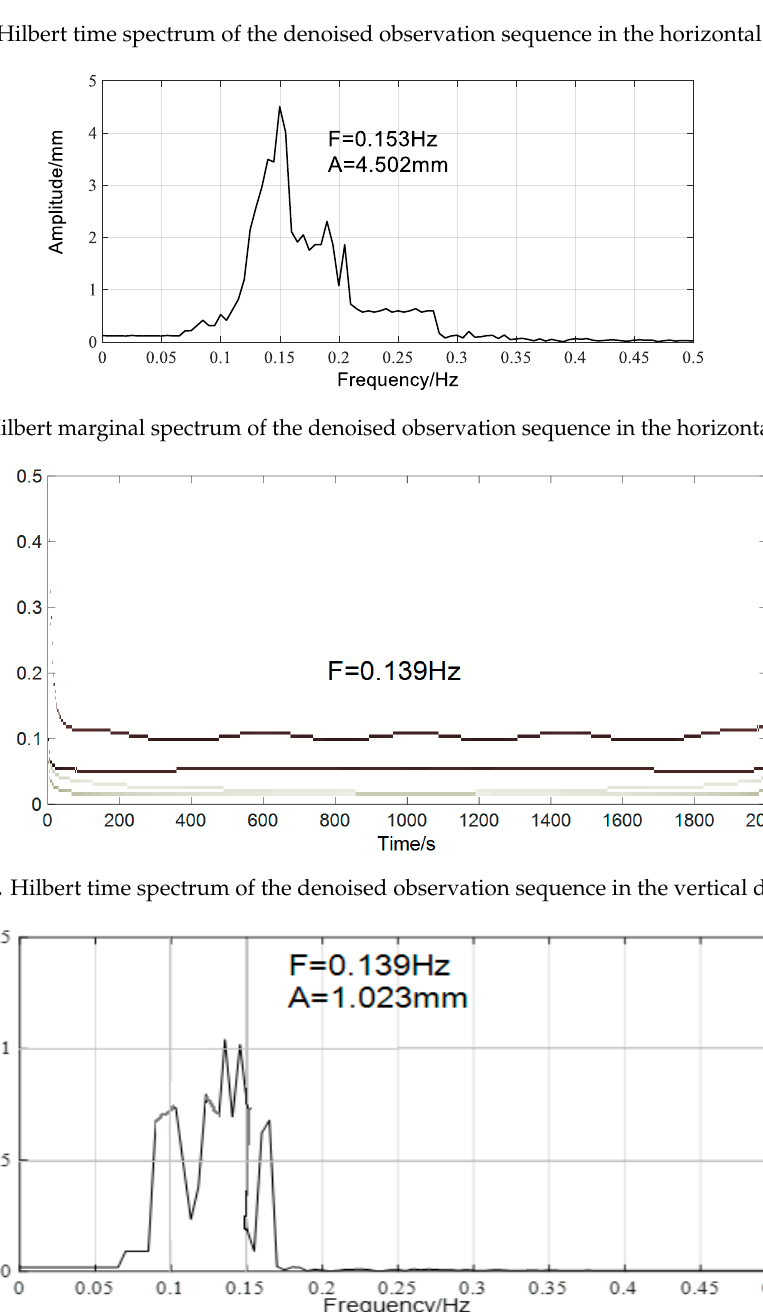
Figure 18. Hilbert marginal spectrum of the denoised observation sequence in the vertical direction.